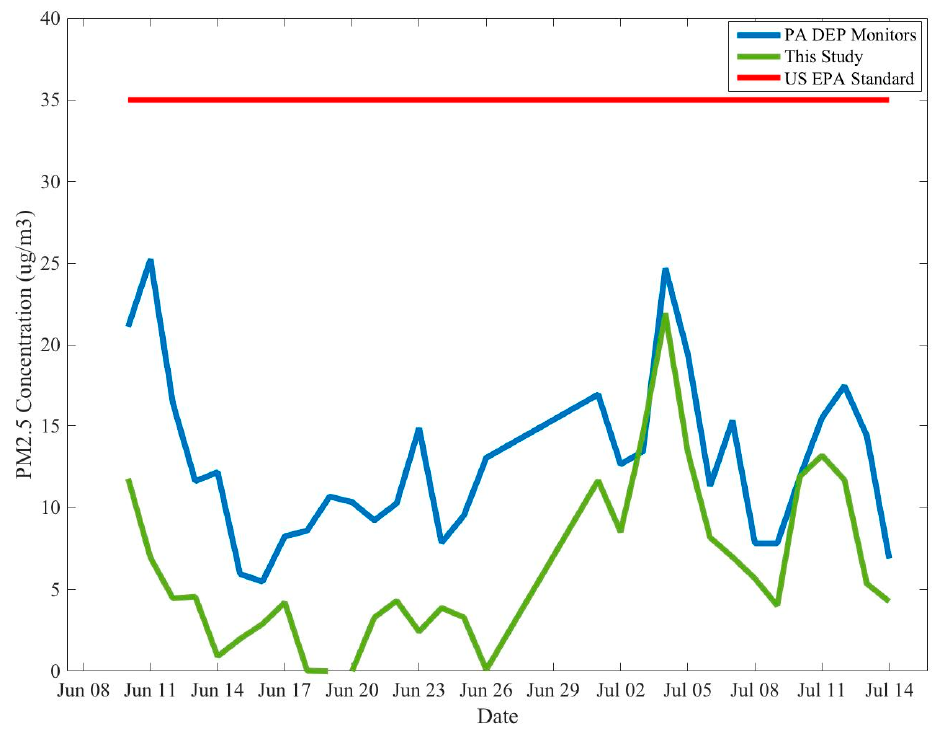
Figure 12. The average concentration measured by the NCSU monitors (this study, green line) compared with the average concentration measured by the PA DEP monitors (blue line line) and the US EPA 24-hour NAAQS (red line) for PM 2.5 .